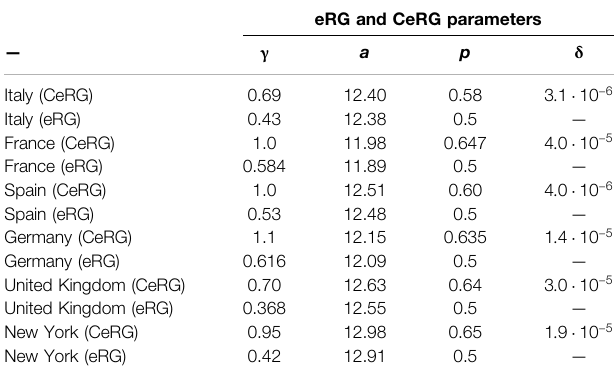
TABLE 1 | CeRG and eRG parameters used to obtain the curves in Figure 5 . eRG and CeRG